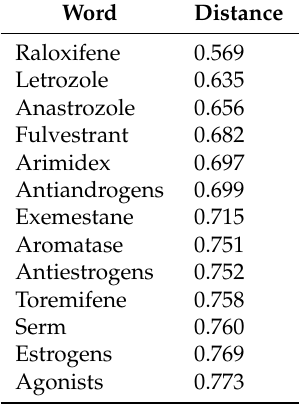
Table 6. Nearest neighbors of “Tamoxifen” using Euclidean distance on the embedding t-SNE space. All of them are hormonal